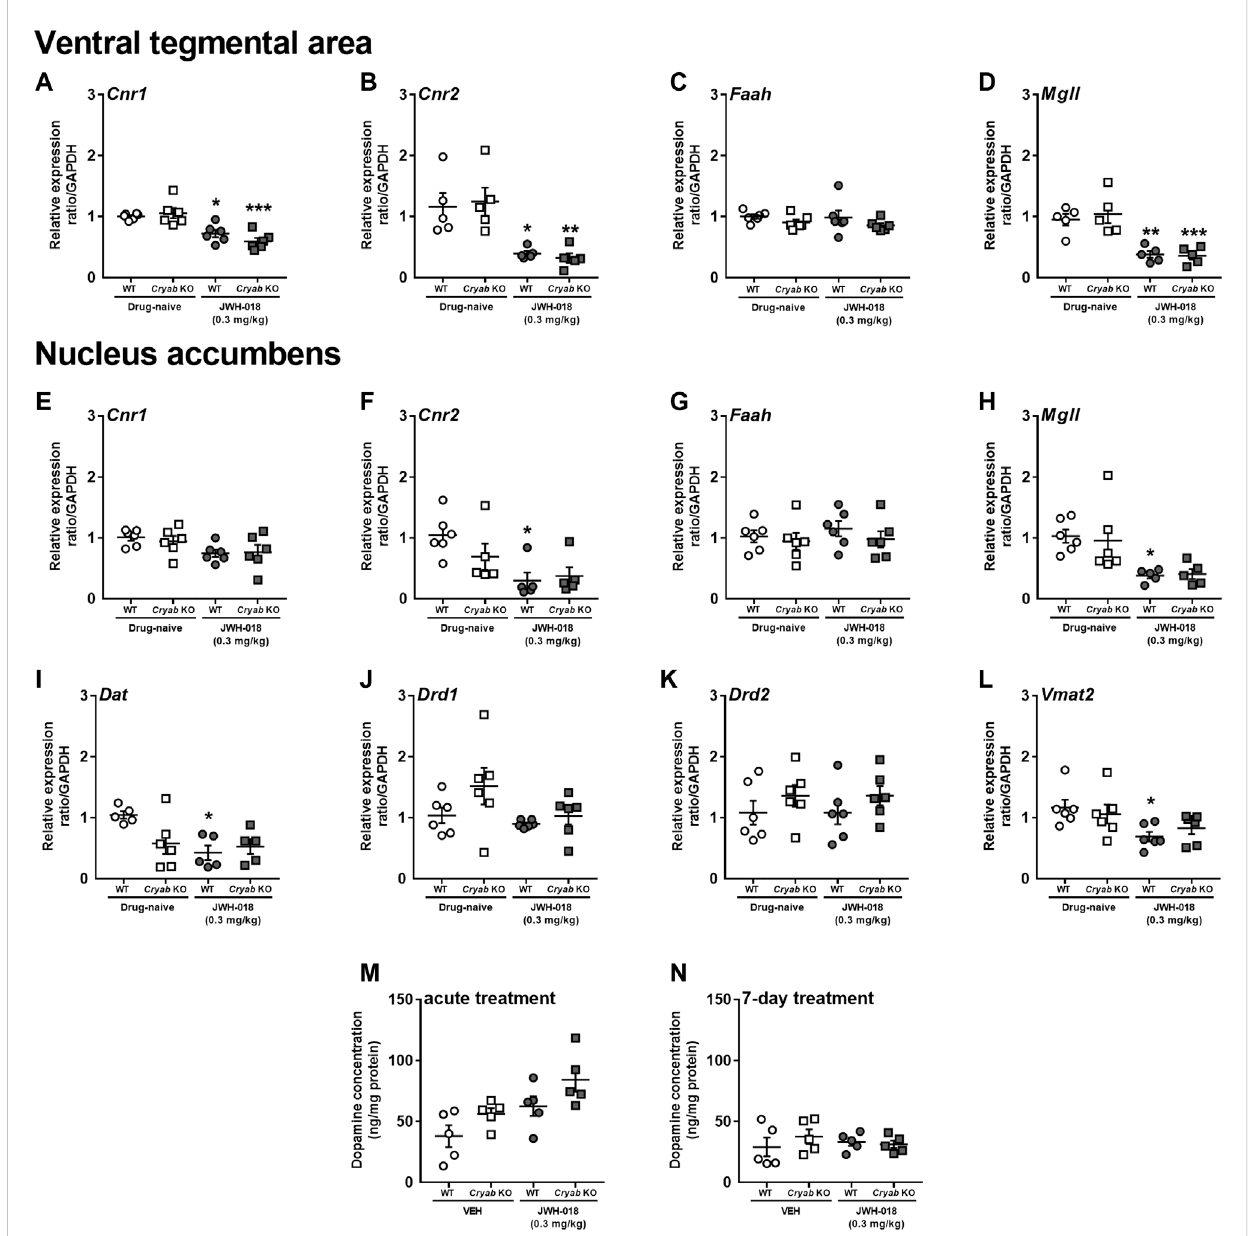
FIGURE 4 Expression levels of endocannabinoid system-related and dopamine-related genes and dopamine concentration in wild-type (WT) and Cryab knockout (KO) mice after repeated JWH-018 treatment. Expressions of Cnr1 , Cnr2 , Faah , and Mgll in the (A – D) ventral tegmental area (VTA) and (E – H) nucleus accumbens (NAC) were determined through quantitative real-time polymerase chain reaction (qRT-PCR) following repeated JWH-018 treatment. The expression levels of (I) Dat , (J) Drd1 , (K) Drd2 , and (L) Vmat2 in the NAC of mice following repeated JWH-018 treatment were also identi fi ed through qRT-PCR. Enzyme-linked immunosorbent assay determined the dopamine concentrations in mouse NAC after (M) acute or (N) repeated JWH-018 treatment. Data expressed as mean ± S.E.M. n = 4 – 6. * p < 0.05, ** p < 0.01, *** p < 0.001 (vs. drug-naïve; Tukey post hoc